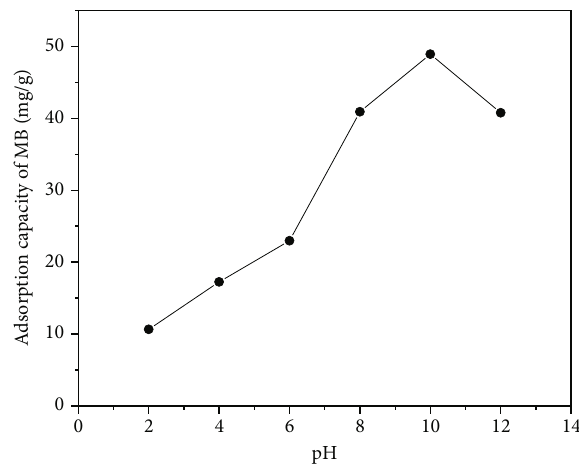
Figure 4: E ff ect of pH on removal of MB (adsorbent dosage 2g, initial concentration 100ppm, and contact time 60 min).